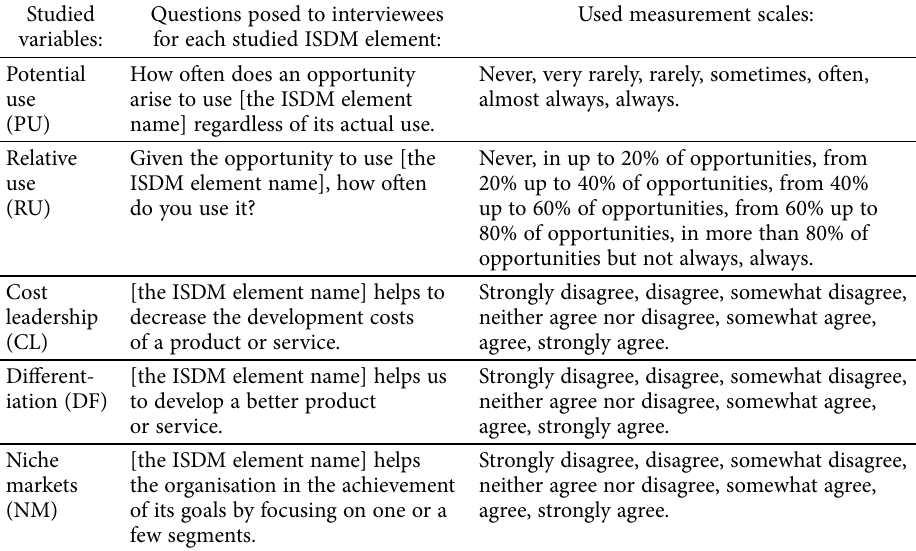
Table 2. The five questions used for the evaluation of each ISDM element